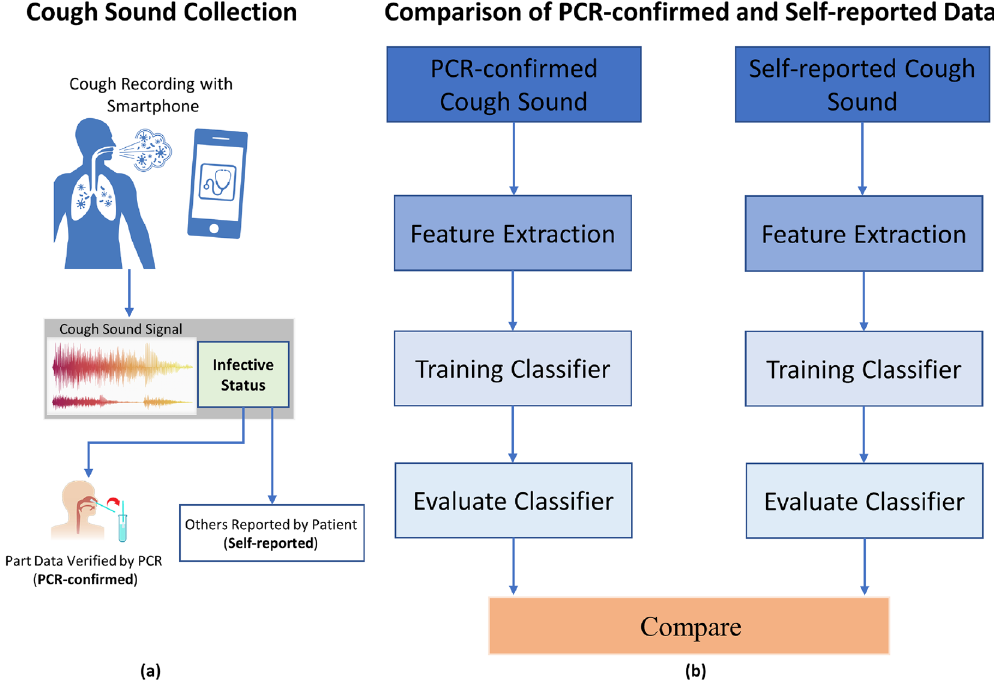
Figure 1. Methodology overview. ( a ) We utilize the cough sounds recorded by smartphones, where the infective status is either validated by a PCR test (PCR-confirmed) or reported by patients (self-reported). ( b ) We then compare the performance of identical classification frameworks harnessing these two types of sound. The frameworks include feature extraction, machine learning classifiers, and controlled evaluation